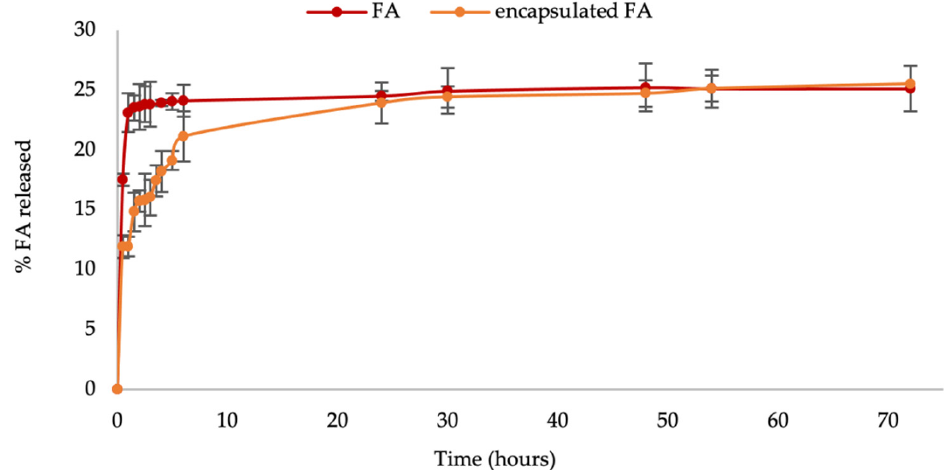
Figure 6. In vitro FA release from encapsulated FA compared to FA.